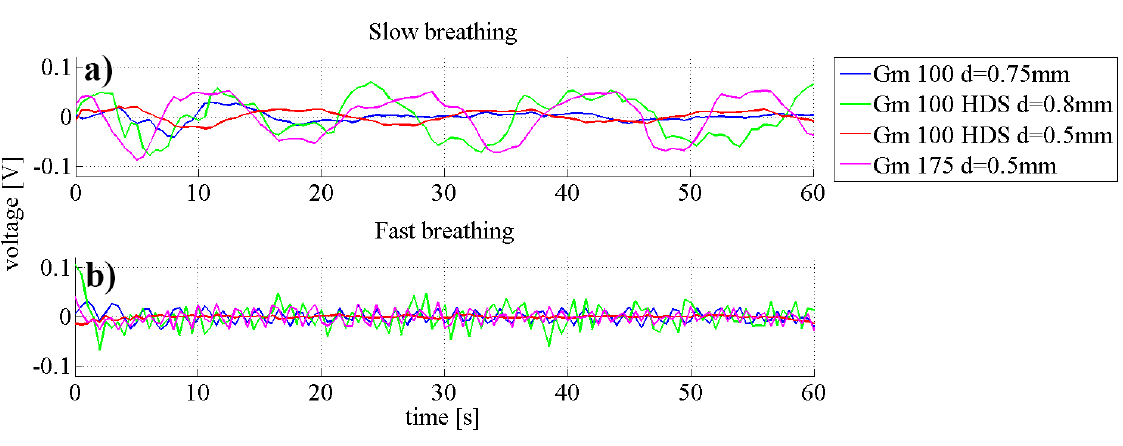
Figure 5. Graphs representing the slow breathing ( a ) and fast breathing ( b ) scenario. All four fibres types were measured for the two